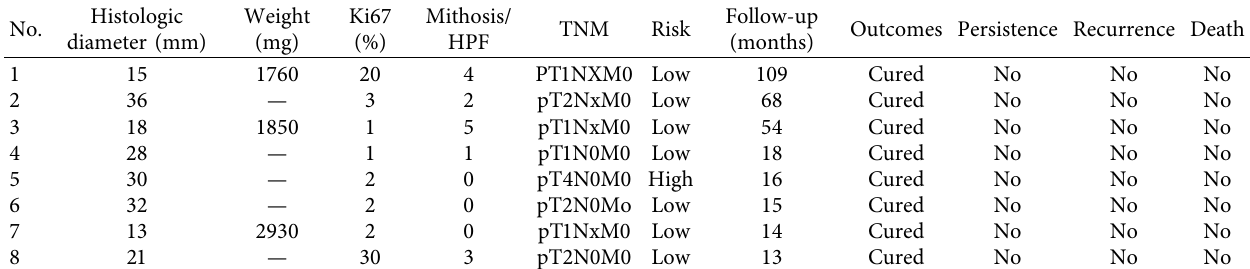
Table 4: Pathological results, risk class, and outcomes of 8 patients affected with PC.